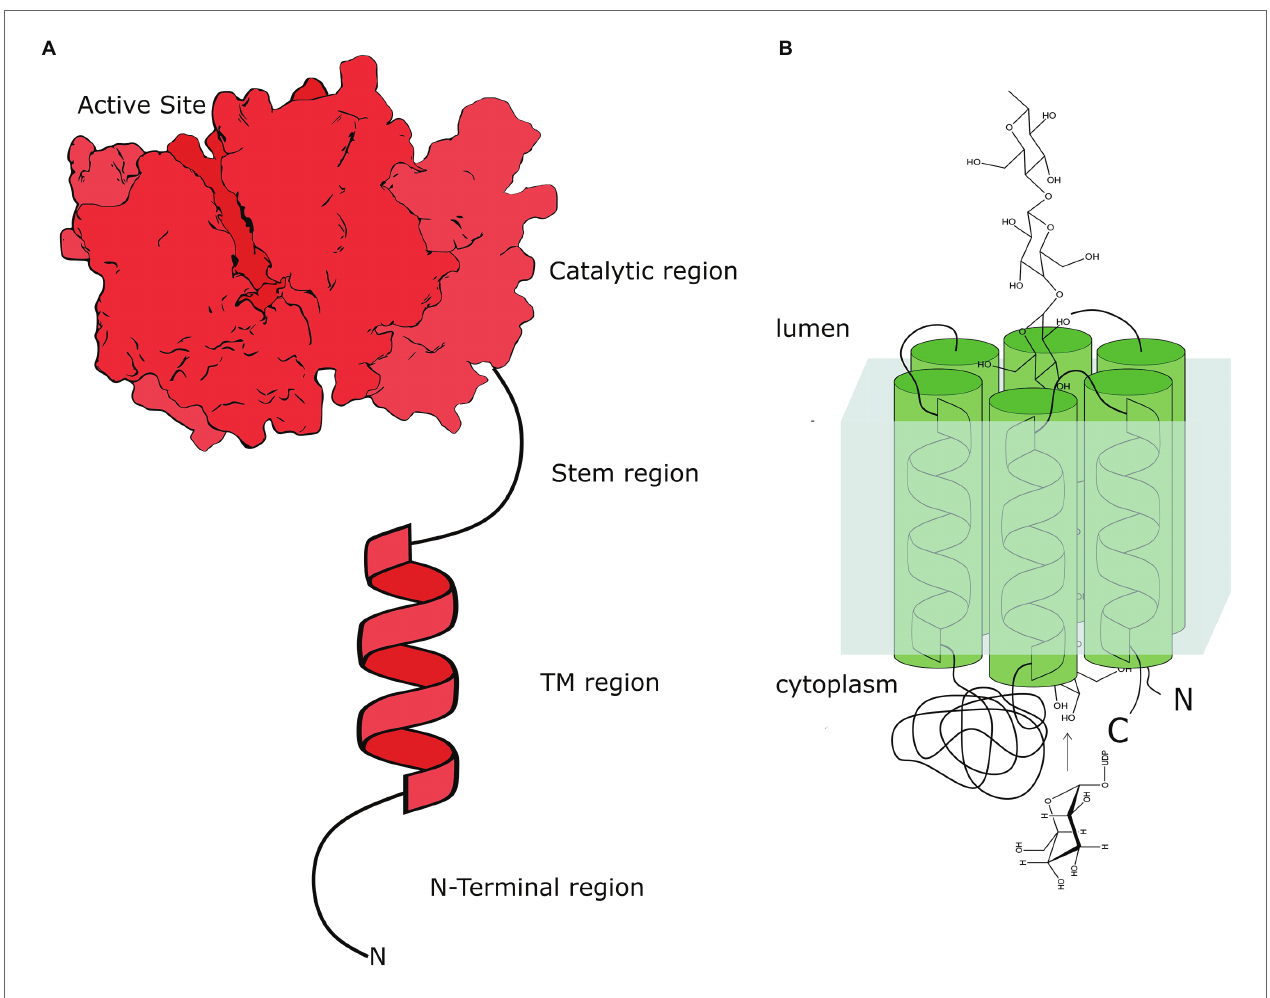
FIGURE 1 | Schematic structural organization of two types of plant glycosyltransferases involved in polysaccharide biosynthesis in plant Golgi. (A) The structural organization of typical glycosyltransferase (GT) as a type II membrane protein with the large soluble catalytic domain attached via the flexible, most likely, unfolded stem region to TMD and the short N-terminus extruded out the membrane. These GTs have a single hydrophobic helix as their TMD. The actual crystal structure of XXT1 (Culbertson et al., 2018) is used here to show the catalytic domain localized in the Golgi lumen. (B) The structural organization of the cellulose synthase-like (CSL) proteins as the integral membrane proteins with multiple TMDs and the soluble catalytic domain that could localize either in the cytoplasm or in the Golgi lumen. Depending on the number of TMD helices spanning the membrane, the C- and N-termini of CSLs can localize on the same or opposite sides of the Golgi membrane (Davis et al.,